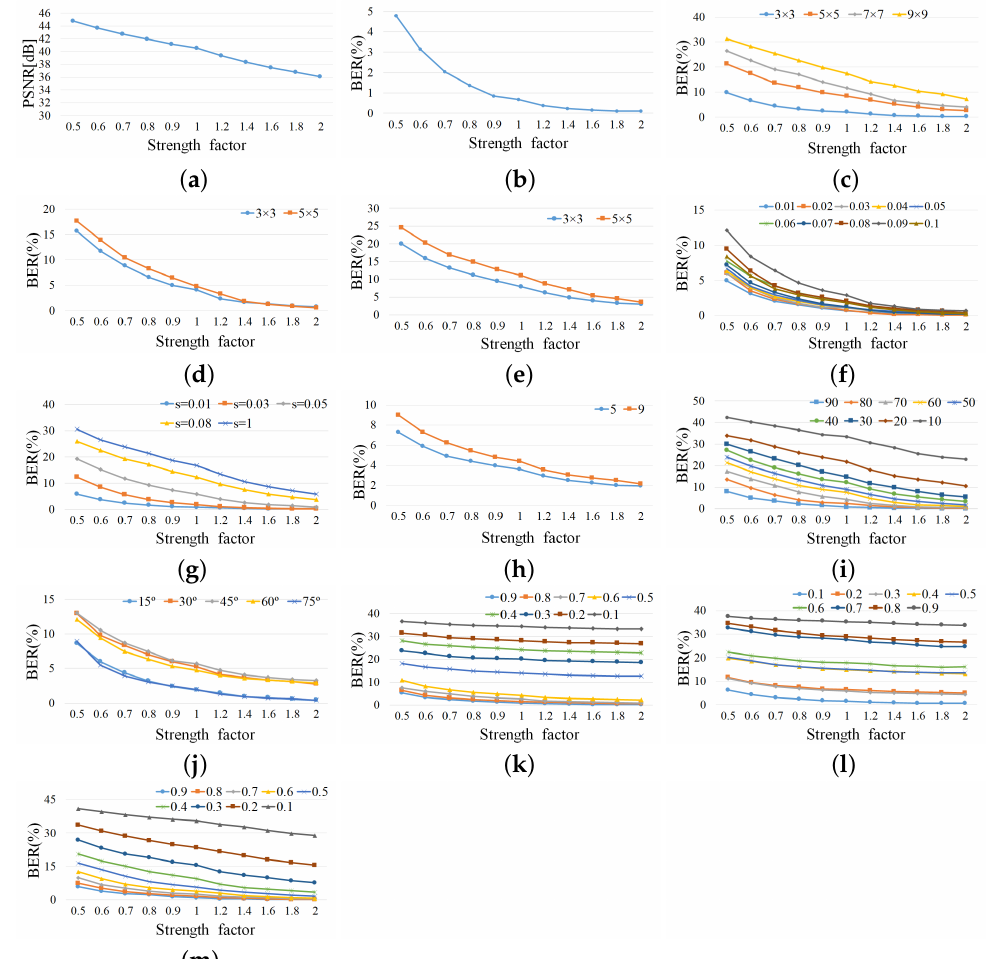
Figure 7. Invisibility and robustness according to a change in the strength factor: ( a ) Invisibility, ( b ) No attack, ( c ) Gaussian Filtering, ( d ) average Filtering, ( e ) median Filtering, ( f ) salt and pepper noise addition, ( g ) Gaussian noise addition, ( h ) sharpening, ( i ) JPEG, ( j ) rotation, ( k ) crop, ( l ) cropout, ( m )